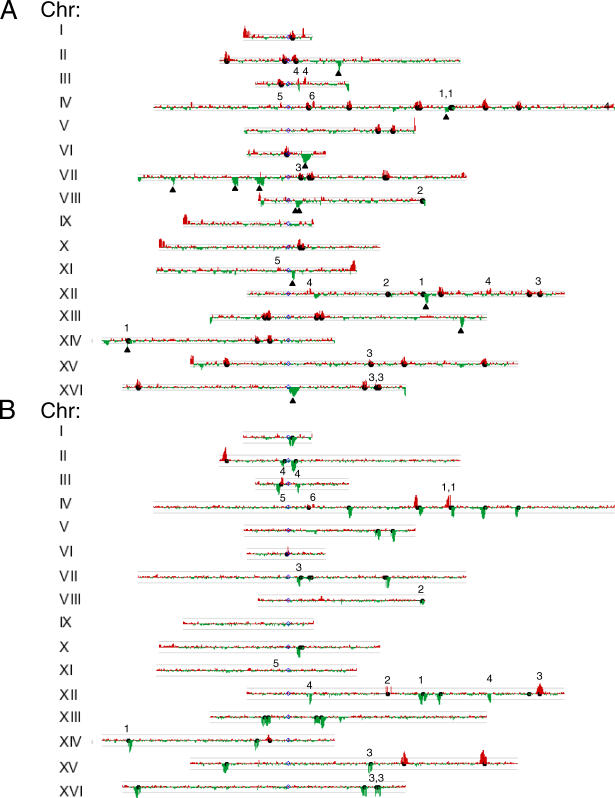
Validation of Whole Genome Transposon Analysis Using Two Sequenced Strains of S. cerevisiae
(A) Whole genome comparison of full-length Ty1 and Ty2 elements from yeast strains RM11 and S288c after hybridization to the same Agilent yeast whole genome microarray. Black circles indicate the position of Ty1 or Ty2 full-length elements annotated for S288c in SGD. Triangles indicate full-length Ty2 elements identified in the sequence of RM11. Red peaks correspond to potential Ty1 or Ty2 elements present in S288c, while green peaks correspond to potential Ty1 or Ty2 peaks present in RM11.(B) Comparison of location of Ty1 full-length elements (green) and Ty2 full-length elements present in S288c. Symbols are as above. Numbers above various peaks refer to the following: 1, false-negative S288c elements obscured by overlapping elements in RM11; 2, false-negative S288c elements located in regions that are poorly represented by features on the array; 3, false-negative S288c elements that missed the criteria for calling a peak; 4, unannotated Ty1 full-length elements in S288c confirmed in this study; 5, false-positive peaks due to borderline elevated differential hybridization; 6, false-positive peaks corresponding to non-Ty repetitive elements in the genome.Grey horizontal lines above and below the central line for each chromosome correspond to a 3-fold difference in normalized ratio of Cy5 and Cy3 signal intensity.